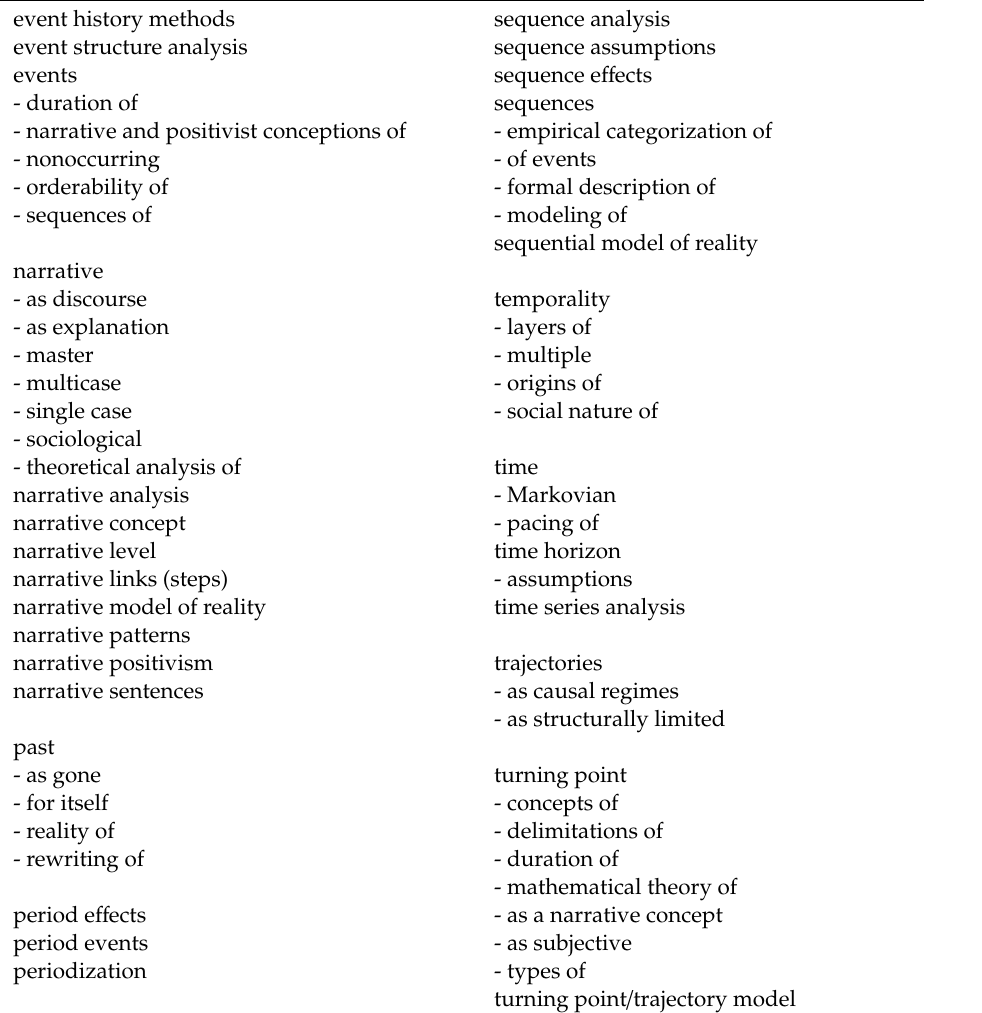
Table 1. Central Time-Related Terminology as Indexed in “Time